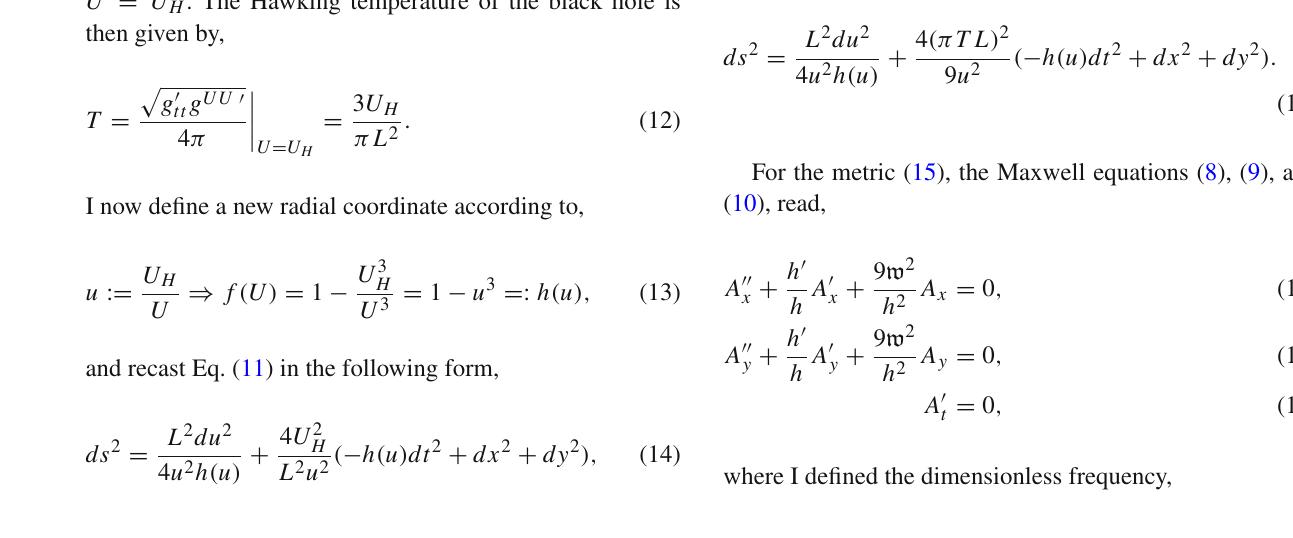
Fig. 2 Real and imaginary parts of the Hall AC conductivity as func- tions the θ -angle and the dimensionless frequency variable, w = 3 ω/ 4 π T , for C (cid:12) = (cid:12) L / 2 = 1 (dimensionless combination involv-